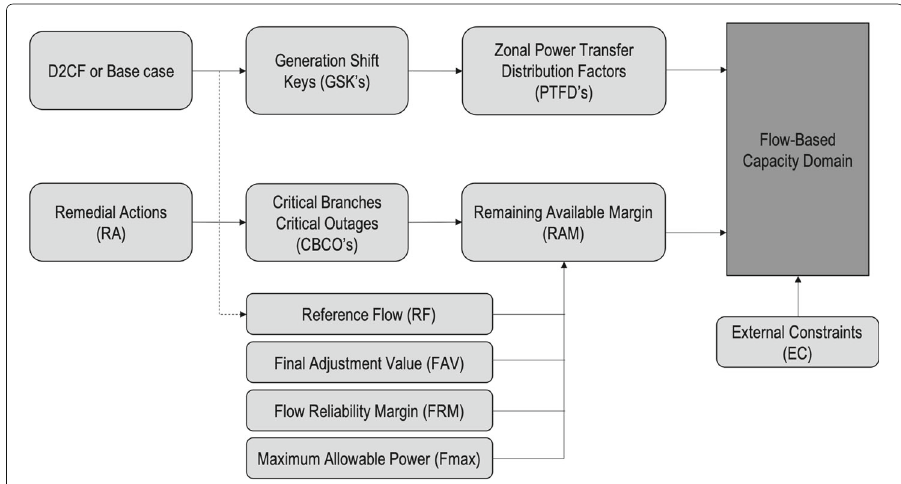
Fig. 1 Interaction of the flow-based parameters for the calculation of the capacity domain (European Commission